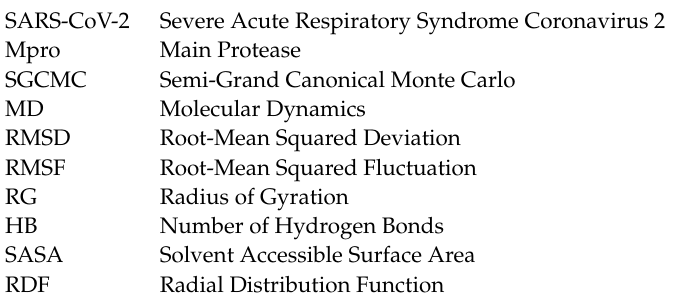
(a) S γ –ions of Cys145. (b) N δ 1–ions of His41. (c) S γ –ions of Met49, Figure S4: 2D representation of PF-00835231, Figure S5: 2D representation of the best binding affinity Mpro–PF-00835231. (a) pH3. (b) pH4. (c) pH5. (d) pH6. (e) pH7, Table S1: Total charge of each titratable amino acids, Table S2: Protonate/deprotonate microstate of His41 and His172. The symbol P and Ddefine the protonated and deprotonated states, respectively, Table S3: Values of the MD was fitted against the average structure of the last 100 ns of the dynamics was used, Table S4: Distances between amino acids from the catalytic dy-ad for each microstate, Table S5: Numerical values of Ramachandran plot of the last frame of each microstate determined by Molprobity server, Table S6: Docking results of each microstate at different